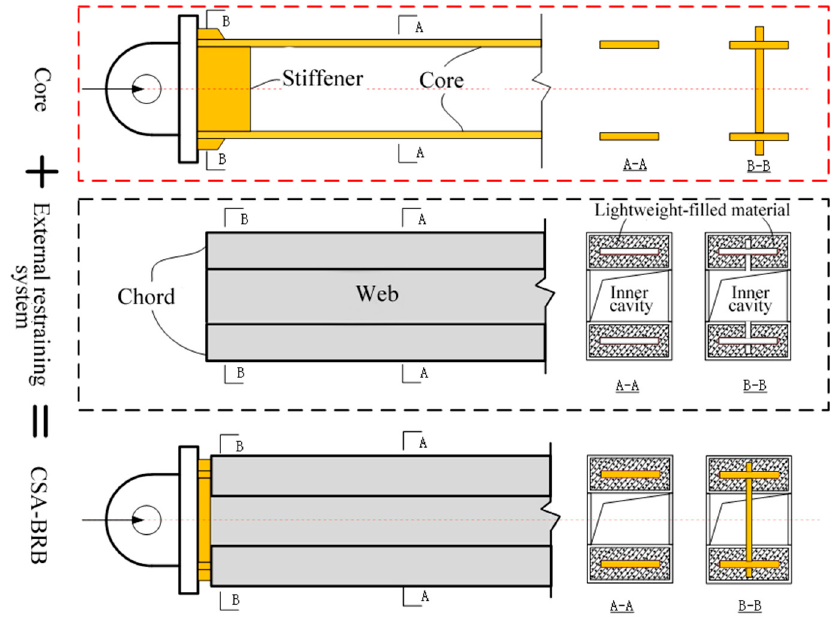
Figure 1. Composition of the proposed CSA-BRB.